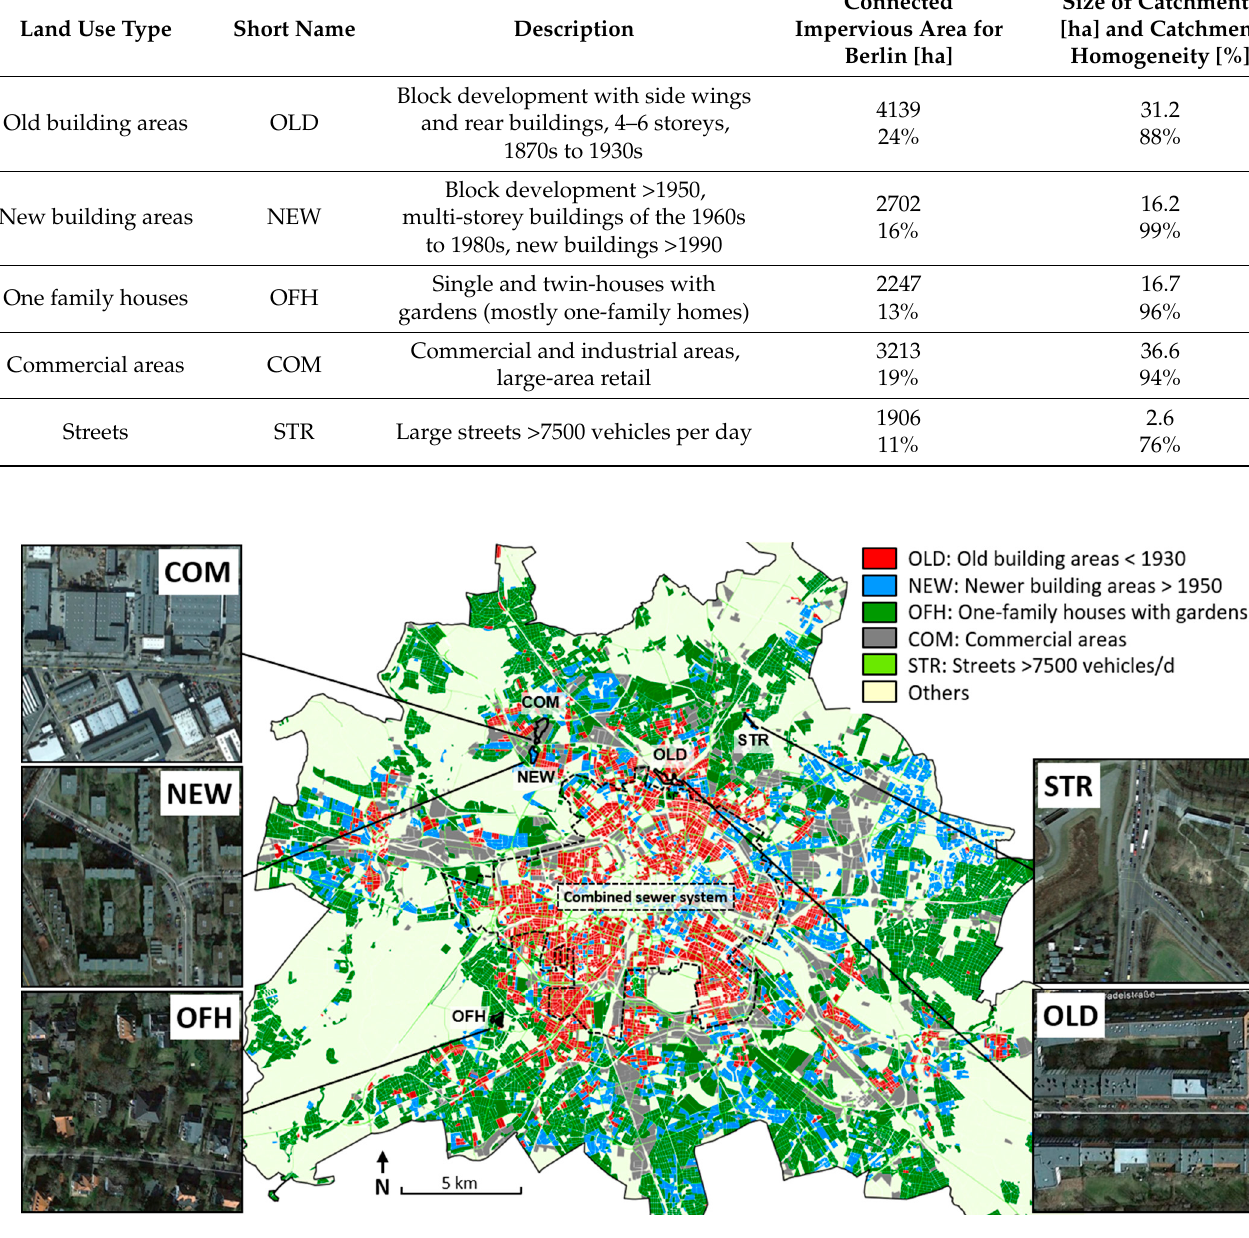
Figure 1. Land-use types and location of monitoring catchments in Berlin (Pictures © Google 2015, Geobasis-DE/BKG).